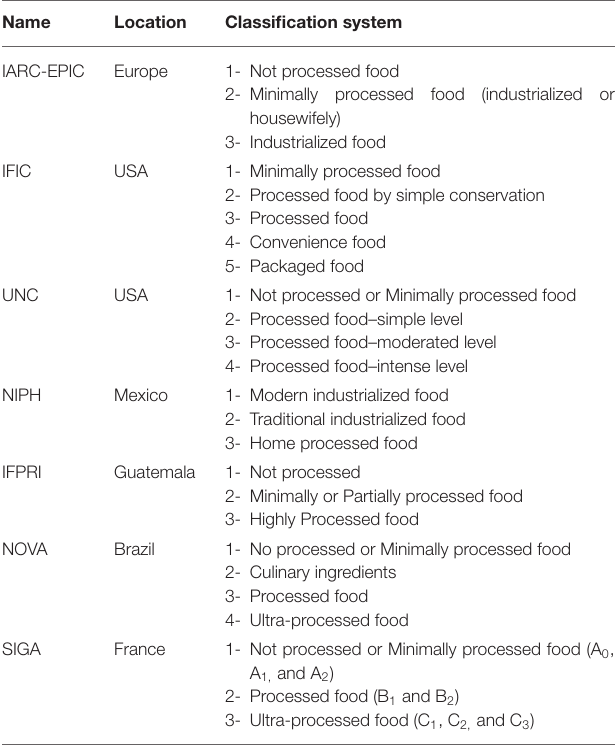
TABLE 2 | Food system classifications according to processing